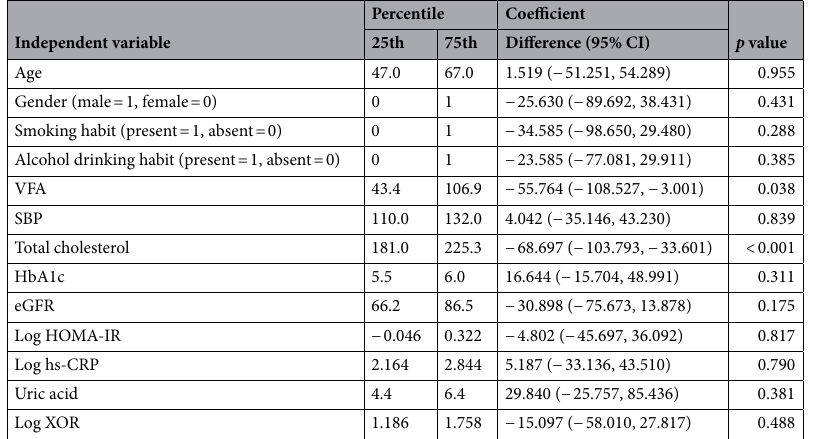
Table 2. Multivariable regression analysis of possible factors associated with BAP level. BAP biological antioxidant potential, VFA visceral fat area, SBP systolic blood pressure, HbA1c glycated hemoglobin, eGFR estimated glomerular filtration rate, HOMA-IR homeostatic model assessment of insulin resistance, hs-CRP high-sensitivity C-reactive protein, XOR xanthine oxidoreductase, CI confidence interval.